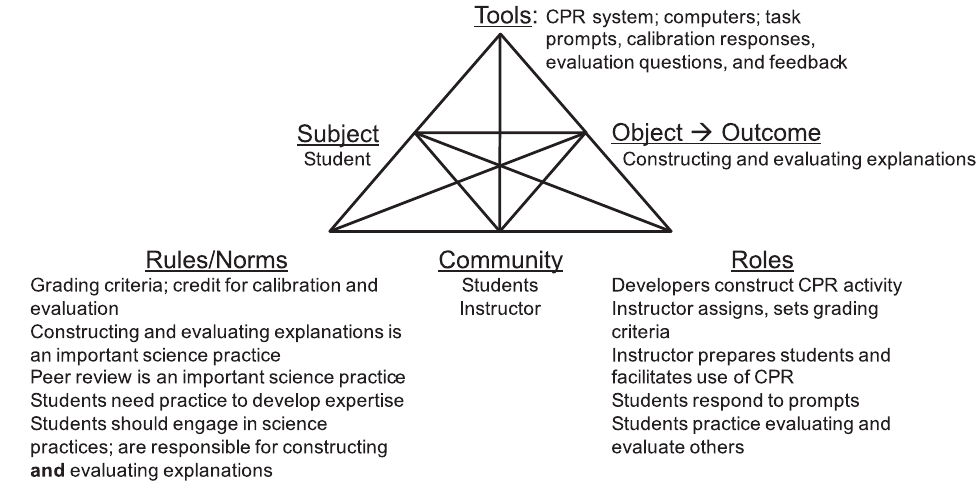
FIG. 2. The elements of the activity system and their